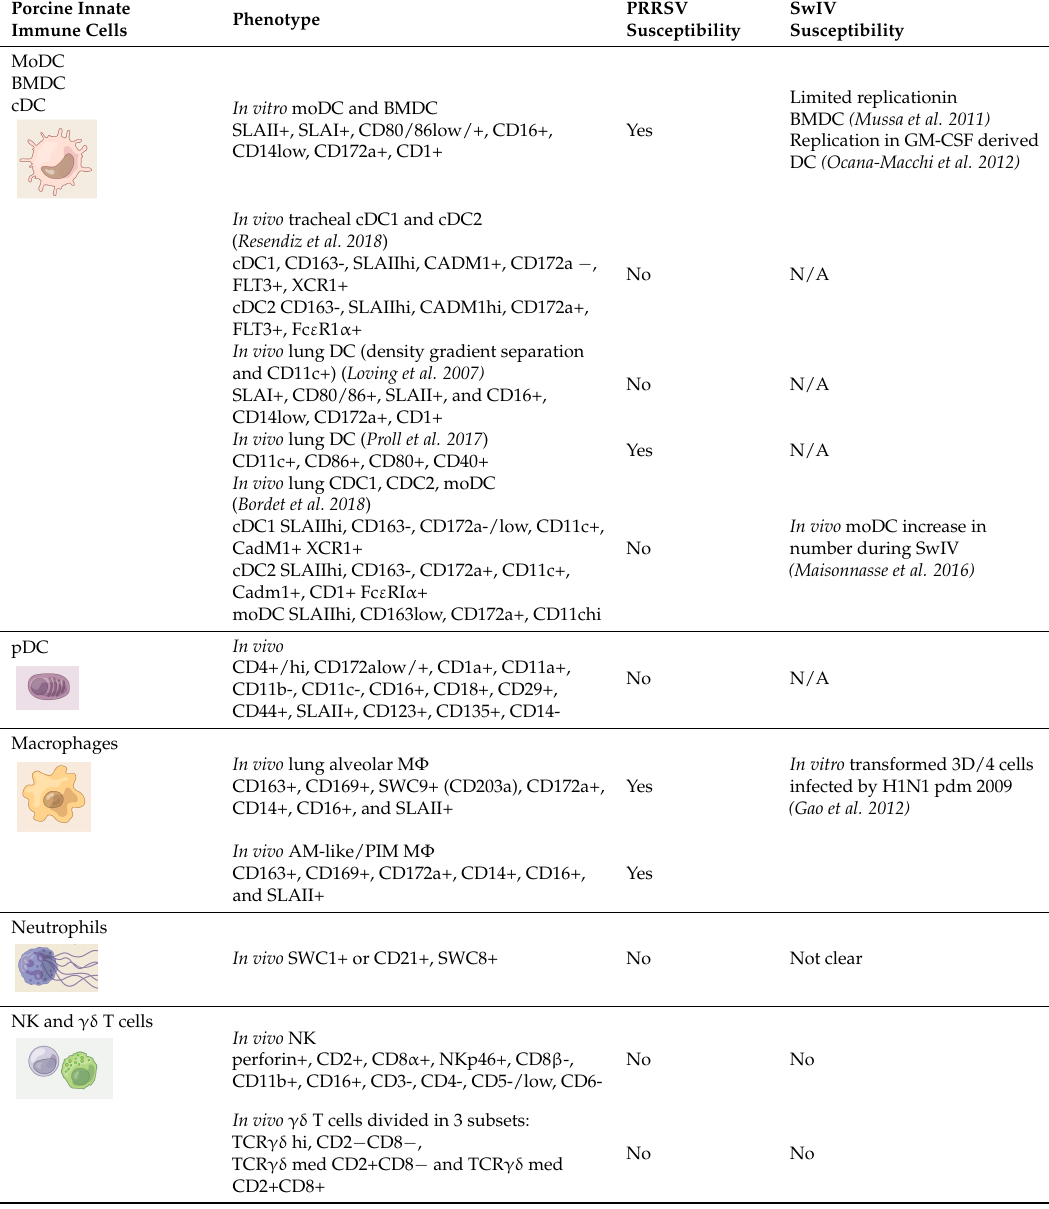
Table 1. Porcine innate immune cells phenotype and porcine reproductive and respiratory syndrome virus (PRRSV) and swine influenza viruses (SwIV) susceptibility. Porcine Innate Immune Cells